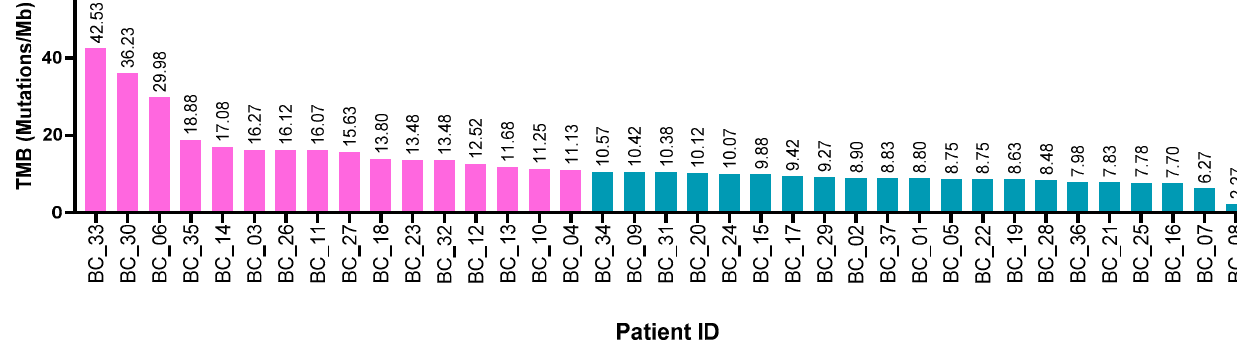
Figure 2. Tumor mutational burden (TMB) patients with bladder cancer treated at the INCan (N = 37) between 2012 and 2021. Bar plot depicts TMB distribution among all the patients. Pink bars represents patients with high TMB, and blue bars represents low TMB.